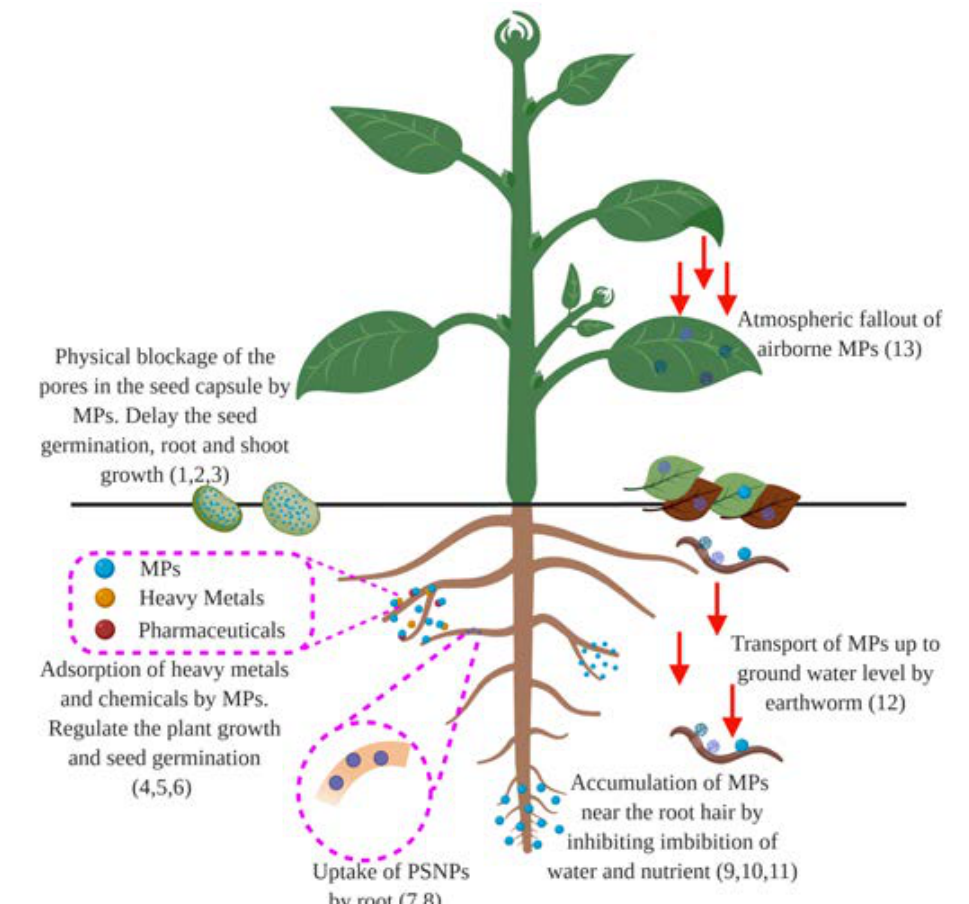
Table 3: Individual effect of microplastics for plant growth in the terrestrial